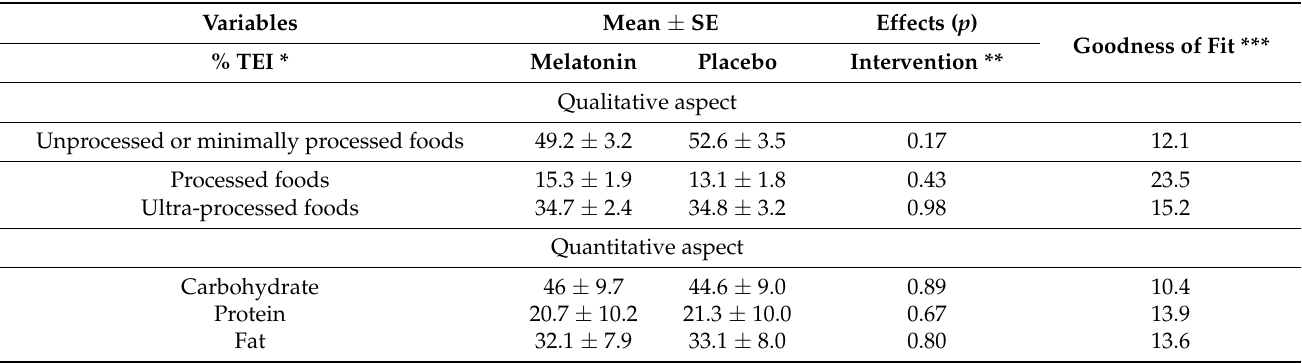
Table 2. Effect of melatonin and placebo administration on the quali/quantitative aspects of the diet.